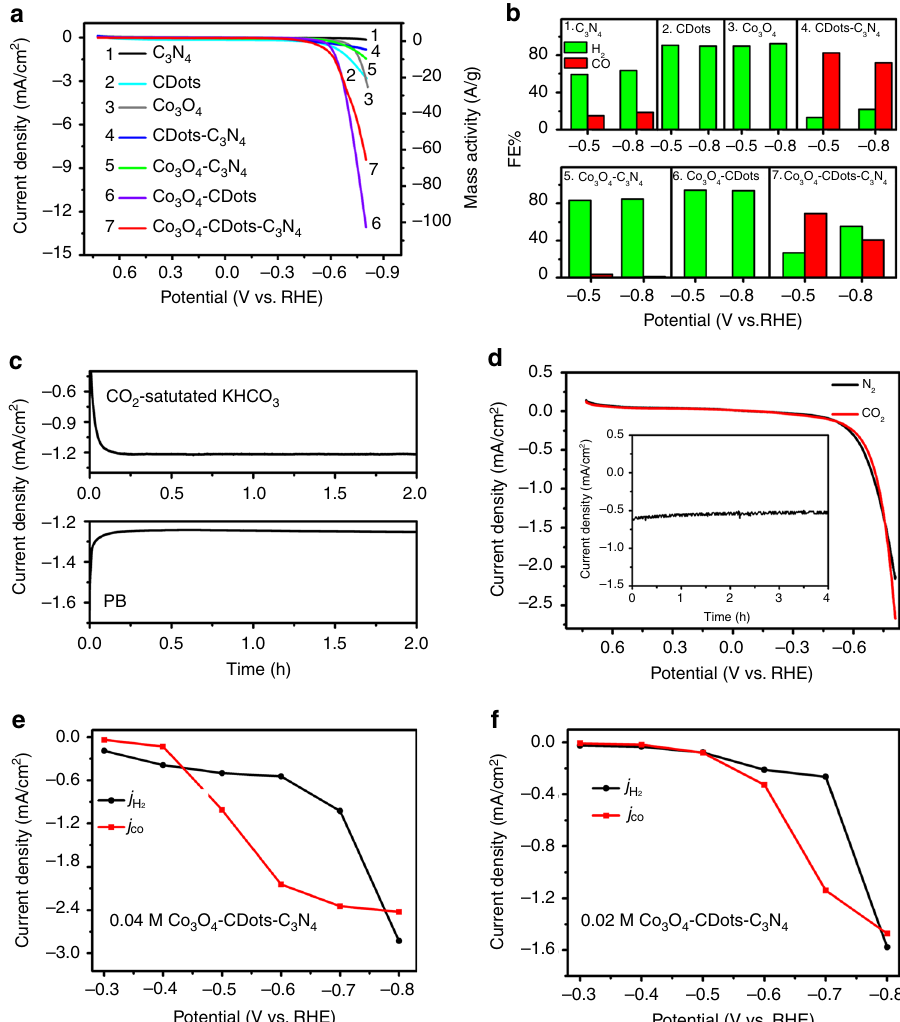
Fig. 4 Electrochemical experiments providing insight into the electrochemical processes. a The linear sweep voltammetry curves (LSVs) for C 3 N 4 (black trace, curve 1), CDots (cyan trace, curve 2), Co 3 O 4 (gray trace, curve 3), CDots-C 3 N 4 (blue trace, curve 4), Co 3 O 4 -C 3 N 4 (green trace, curve 5), Co 3 O 4 - CDots (purple trace, curve 6), and Co 3 O 4 -CDots-C 3 N 4 (red trace, curve 7) in CO 2 -saturated 0.5 M KHCO 3 electrolyte, 10 mV/s. Current density on left y axis and mass activity on right y axis. The comparison of the curves allows determination of the role of the different catalyst components in the electrochemical reactions. b The FEs of the reaction products at − 0.5 and − 0.8 V, using C 3 N 4 , CDots, Co 3 O 4 , CDots-C 3 N 4 , Co 3 O 4 -C 3 N 4 , Co 3 O 4 -CDots, and Co 3 O 4 -CDots-C 3 N 4 , respectively, as catalysts. Note that only the C 3 N 4 and CDots-C 3 N 4 composites produce signi fi cant amounts of CO. c Total current density vs. time curves of CO 2 reduction to CO and HER at the potential of − 0.6 V in CO 2 -saturated KHCO 3 solution (0.5 M, pH = 7.2) and phosphate buffer (PB) solution (pH = 7.2), respectively. d LSVs for the Co 3 O 4 -CDots-C 3 N 4 in N 2 - (black trace) and CO 2 -saturated (red trace) MeCN containing 0.5 M [BMIM]PF 6 , 10 mV/s. The inset shows the total current density vs. time curves of CO 2 reduction at the potential of − 0.6 V in CO 2 -saturated MeCN containing 0.5 M [BMIM]PF 6 . The current in the inset is much smaller than in c and no reaction products are detected indicating that H + is essential for both HER and CO 2 reduction to CO. e Current density for HER ( j H2 , black trace) and current density for CO 2 reduction, ( j CO , red trace) vs. the applied potential, catalyzed by 0.04 M Co 3 O 4 -CDots-C 3 N 4 in a CO 2 -saturated 0.5 M KHCO 3 electrolyte. f Current density for HER ( j H2 , black trace) and current density for CO 2 reduction, ( j CO , red trace) vs. the applied potential, catalyzed by 0.02 M Co 3 O 4 -CDots-C 3 N 4 in CO 2 -saturated 0.5 M KHCO 3 electrolyte; note that the reduction of the amount of the HER catalyst component shifts the balance of gas generation toward enhanced CO both the current density and the FE for 30 h (it is very likely that the FE is stable for 100 h as well).